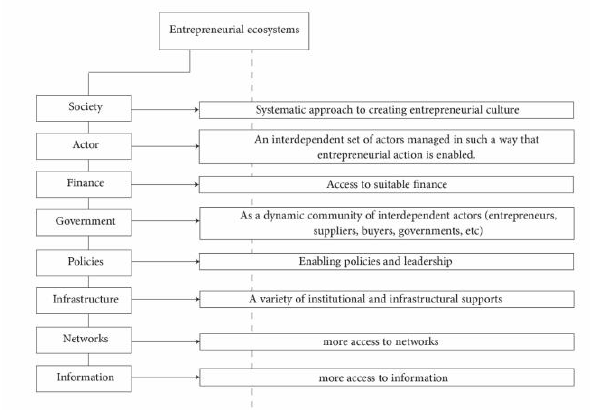
Figure 1 . Entrepreneurial ecosystem element, illustrated by authors